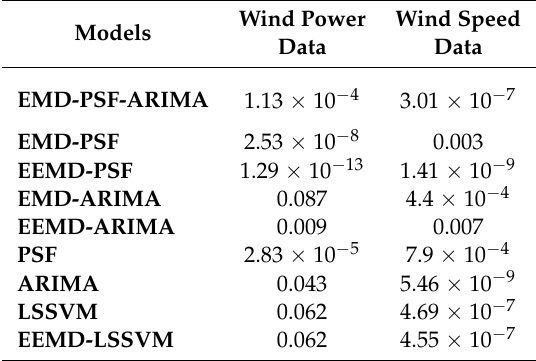
Table 6. One-way ANOVA test ( p -values) with respect to EEMD-PSF-ARIMA model.